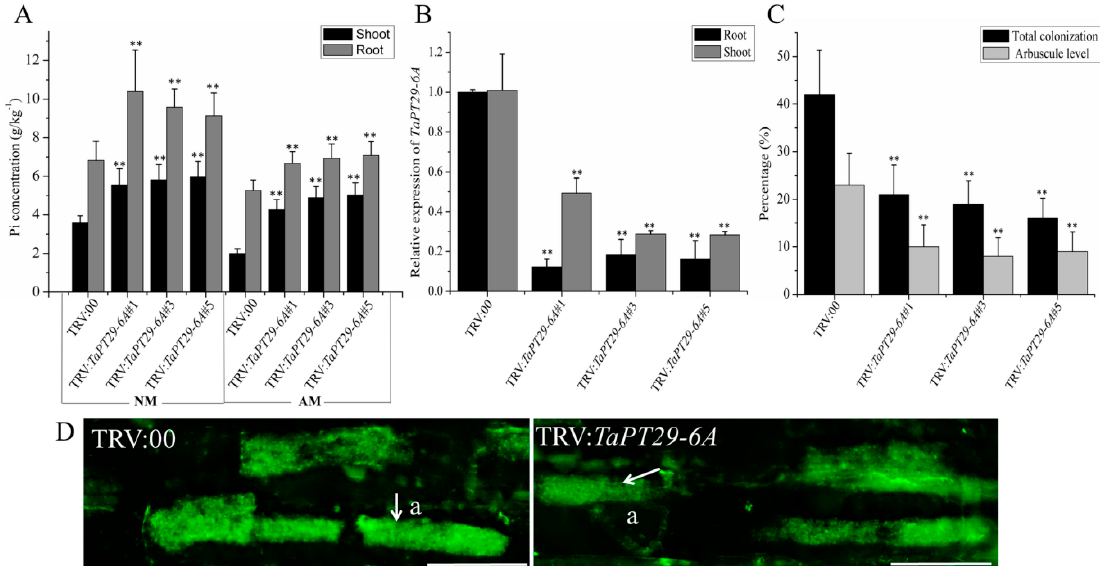
Figure 7. Arbuscular mycorrhizal phenotypes of TaPT29-6A -silenced plants. Fluorescence microscopic images showing arbuscules in wheat roots silenced with a TaPT29-6A partial sequence and controls infected with the TRV:00 vector. ( A ) Pi concentrations in indicated tissues of TaPT29-6A -silenced and control plants in the presence and absence of F. mosseae at 42 dpi. ( B ) Relative transcript levels of TaPT29-6A in control and silenced plants. Bars indicate means of three biological replicates with standard errors. ( C ) Levels of F. mosseae colonization and arbuscules at 42 dpi in TaPT29-6A -silenced and control plants. ( D ) Wheat roots of TaPT29-6A -silenced and control plants stained with WGA-Alexafluor 488 to view F. mosseae arbuscules in their cells at 6 wpi. Double asterisks indicate significant differences relative to TRV:00 plants ( P ≤ 0.01 according to t tests). a = arbuscules. Bars = 12.5 µm. NM, non-colonized; AM, colonized.